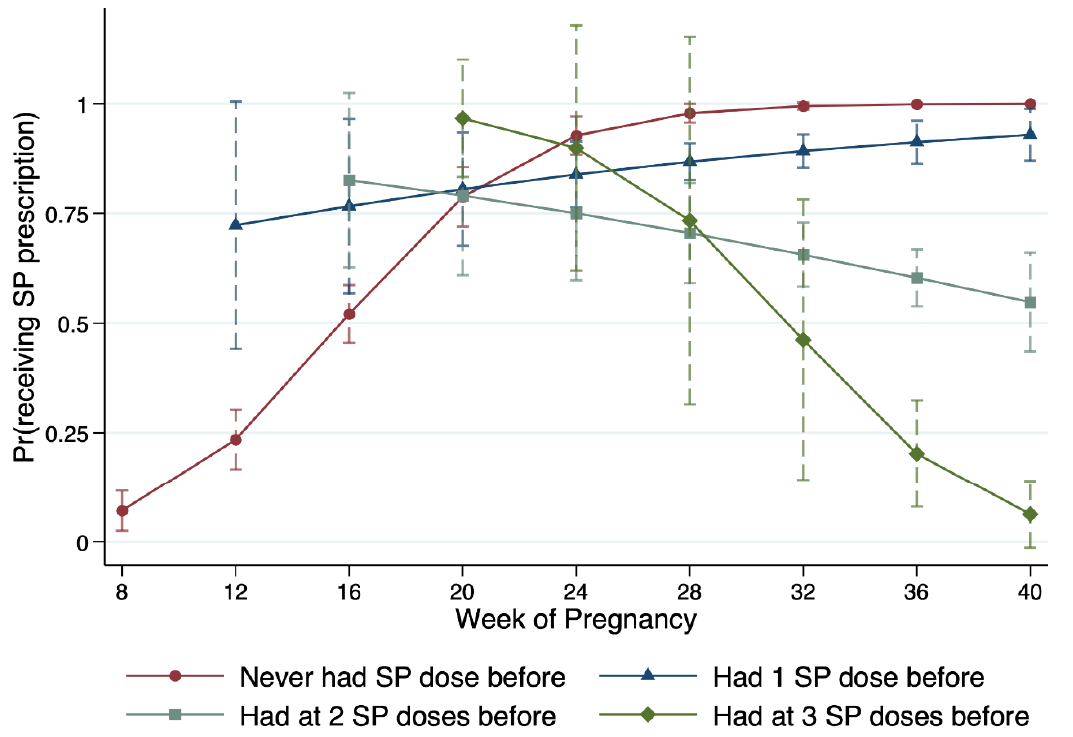
Figure 2. Predicted Probability of Receiving IPTp Prescription Varies by Gestational Age and IPTp History. Note: This figure presents the marginal mean probabilities and corresponding confidence intervals of IPTp prescription along the week of pregnancy. The x-axis is the gestational age measured at 4-week intervals. Color coding and line patterns are the same as in Figure 1 for the same category of IPTp history.